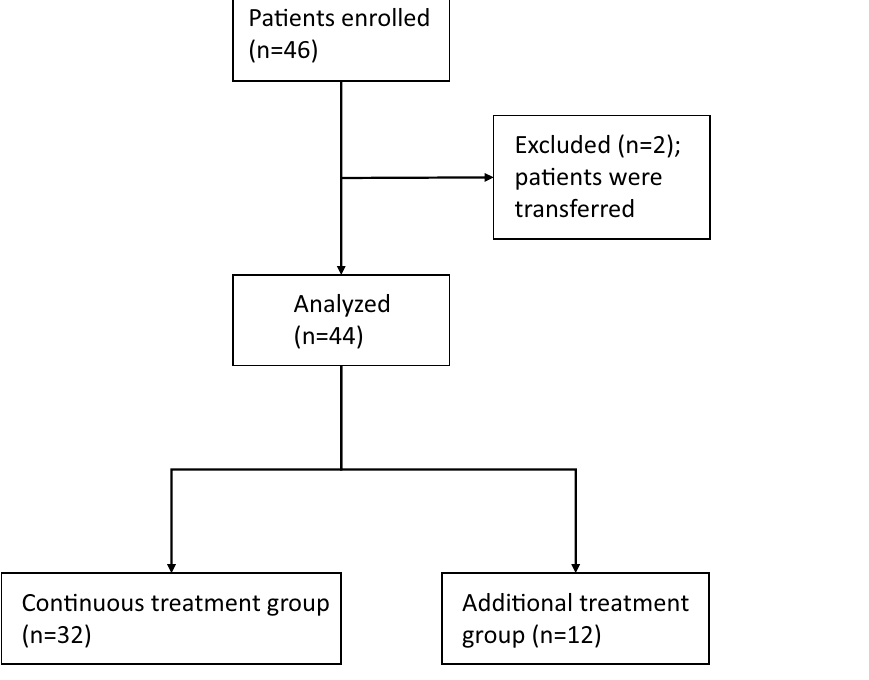
Figure 1. Research design summary and treatment